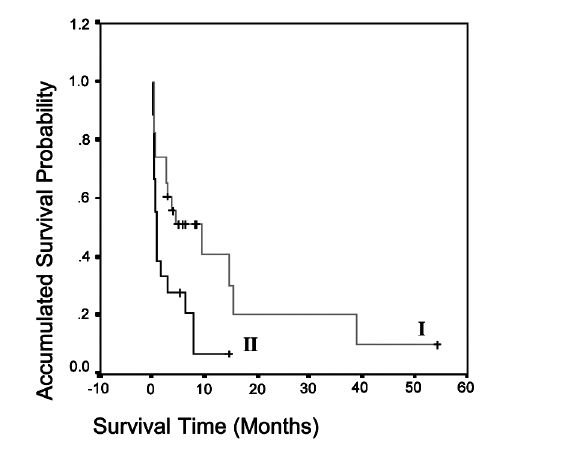
Figure 3 – Survival of patients with 52 years of age or less (I), and patients over 52 years of age (II), p = 0.008.